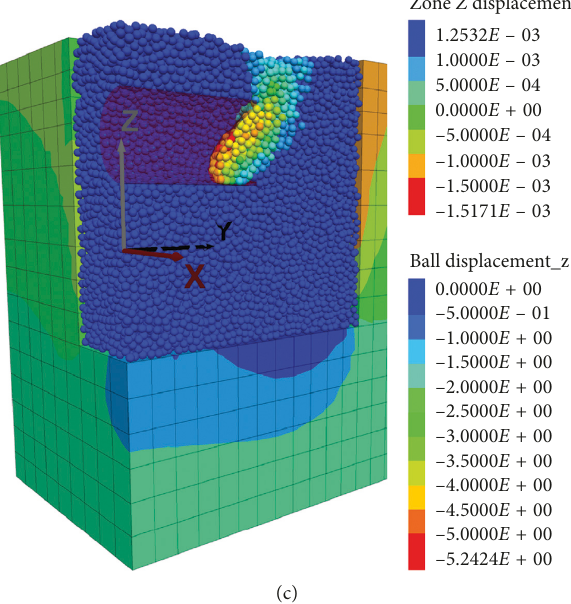
Figure 20: Instability of excavation surface at different depths.